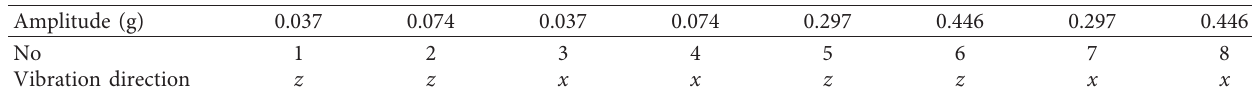
Table 2: Loading sequence of Huaping slope.